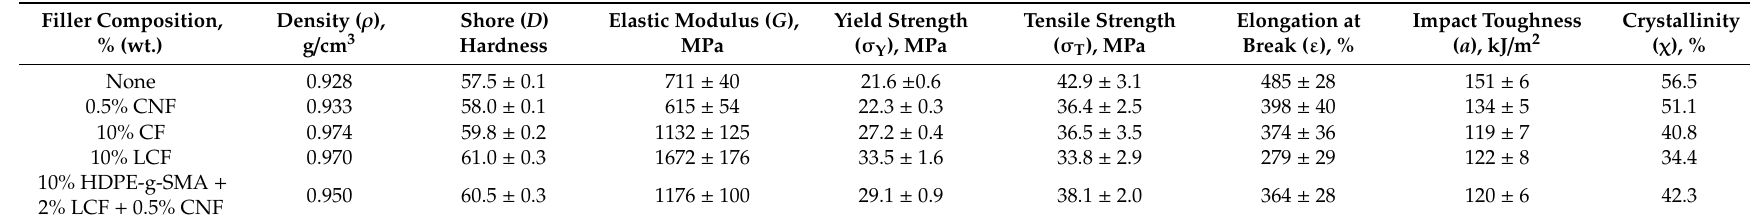
Table 2. Mechanical properties of UHMWPE and UHMWPE-based composites.